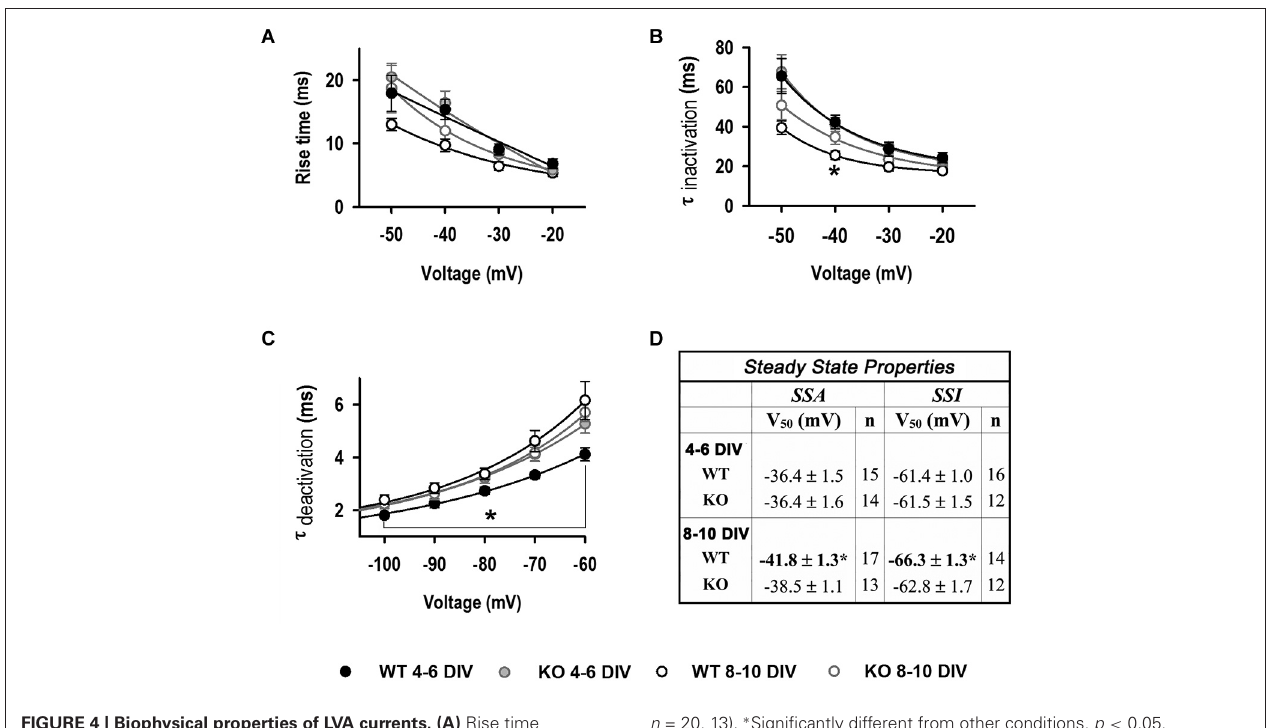
FIGURE 4 | Biophysical properties of LVA currents. (A) Rise time (10–90%) values as function of voltage. (B) τ inactivation as function of voltage. 4–6 DIV ( n = 19, 22); 8–10 DIV ( n = 10, 10) for A , B . (C) τ deactivation as function of voltage (4–6 DIV: n = 14, 19; 8–10 DIV: